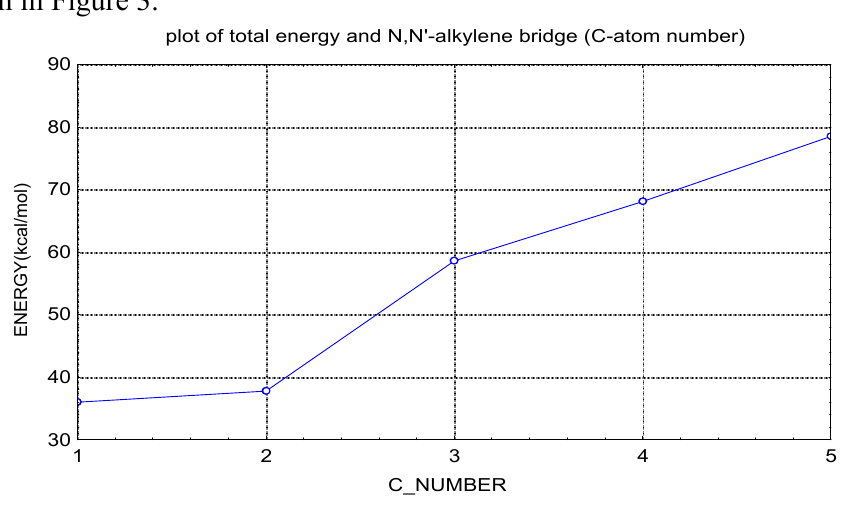
Figure 3. The relationship between molecular energy and N, N’-alkylidene bridge